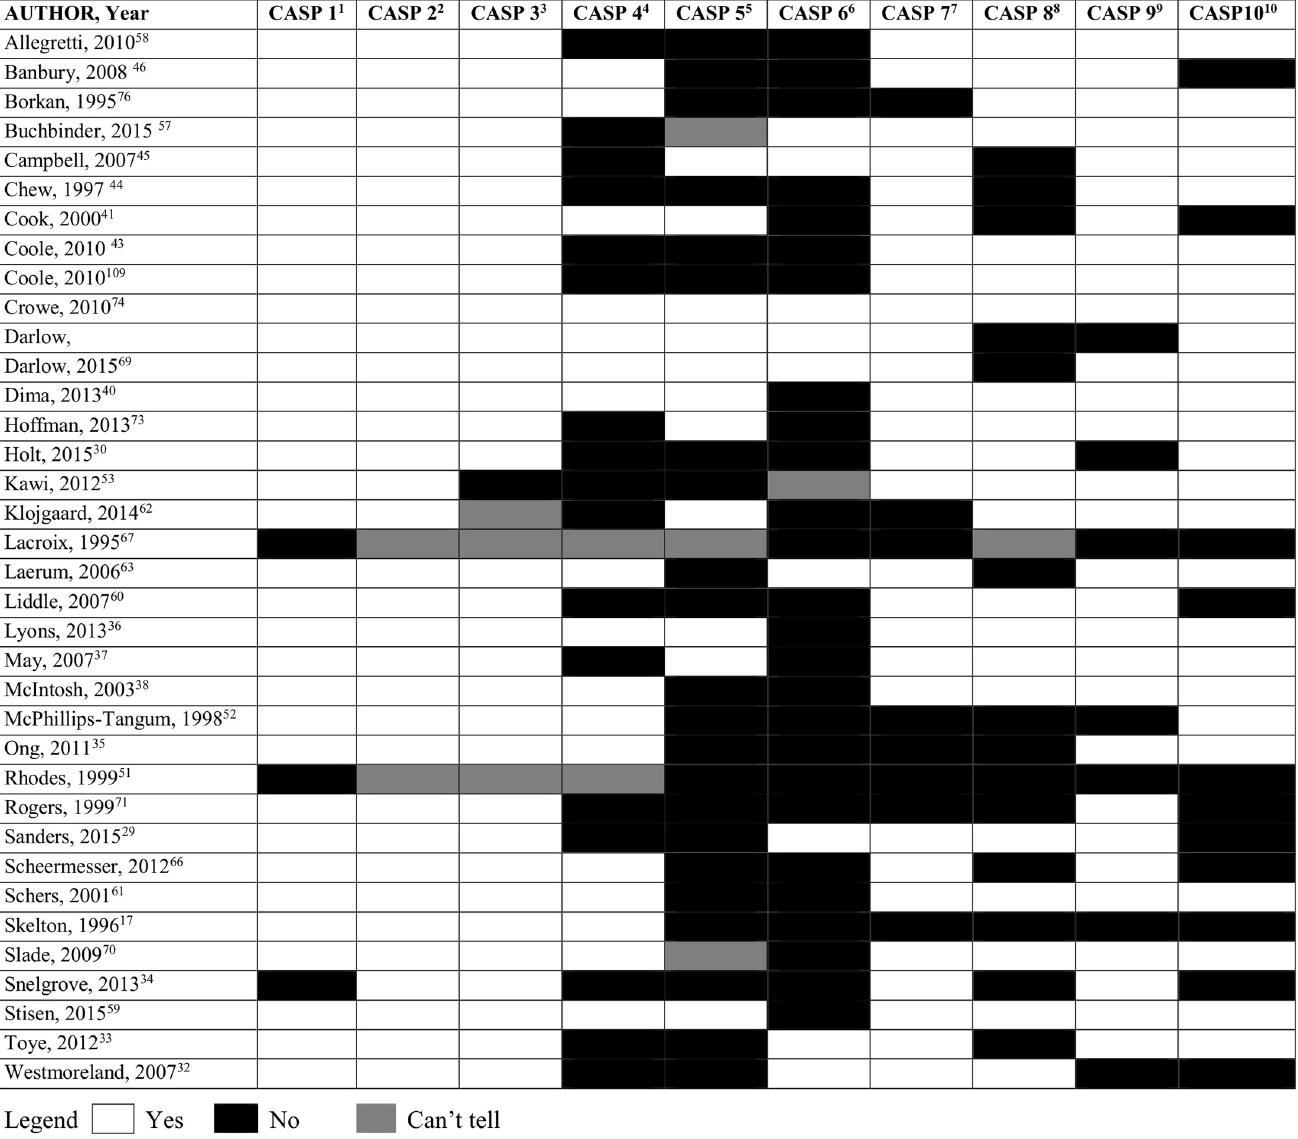
Fig 2. CASP tool for qualitative studies. 1 CASP 1: Was there a clear statement of the aims of the research 2 CASP 2: Is a qualitative methodology appropriate? 3 CASP 3:Was the research design appropriate to address the aims of the research? 4 CASP 4: Was the recruitment strategy appropriate to the aims of the